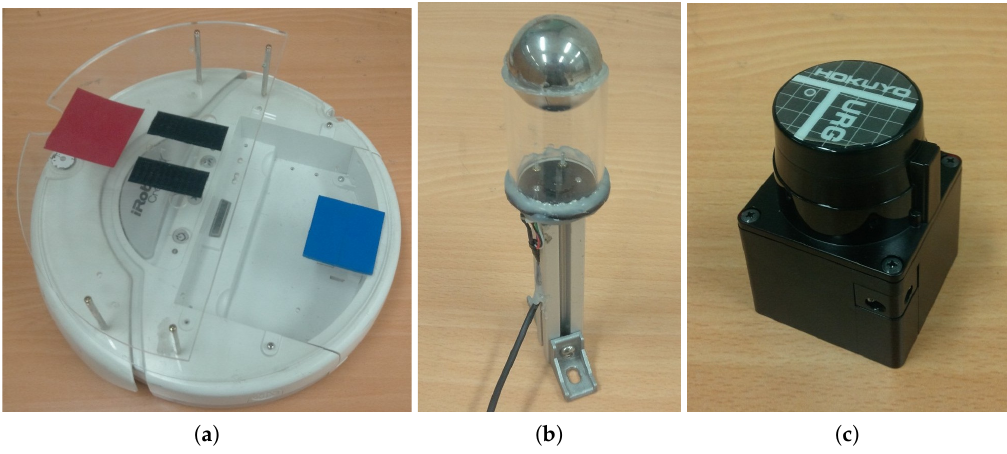
Figure 2. Mobile robot platform: ( a ) i-Robot ROOMBA mobile; ( b ) omnidirectional camera; ( c ) HOKUYO laser sensor.